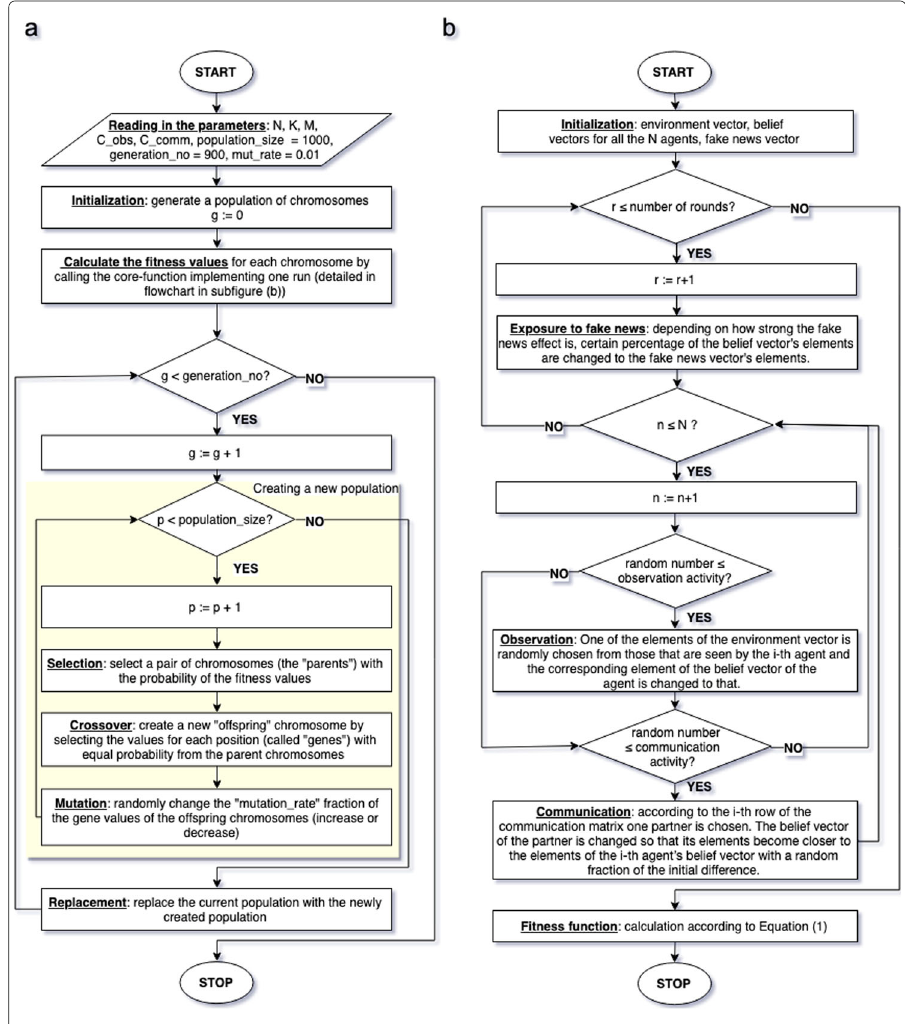
Fig. 5 The flowchart of the a genetic algorithm and b the routine assigning a fitness value for each chromosome. a Genetic algorithms – a popular and widely applied optimization approach – are designed to optimise a population of chromosomes with respect to a pre-defined fitness function. b A crucial part of all genetic algorithms is the way a fitness value is assigned to a chromosome: the input of this function is an instance of chromosome ( A and B matrices) and the output is the corresponding fitness value measuring the "quality" of the input. The first two decision boxes (diamond shapes) stand for two for-loops, while the second two decision boxes stand for two